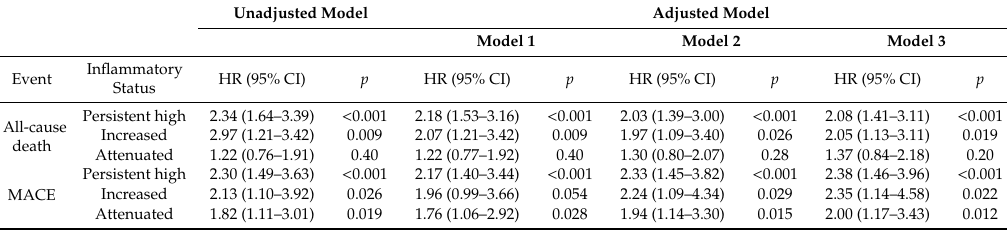
Table 2. Unadjusted and adjusted models for outcomes according to residual inflammatory